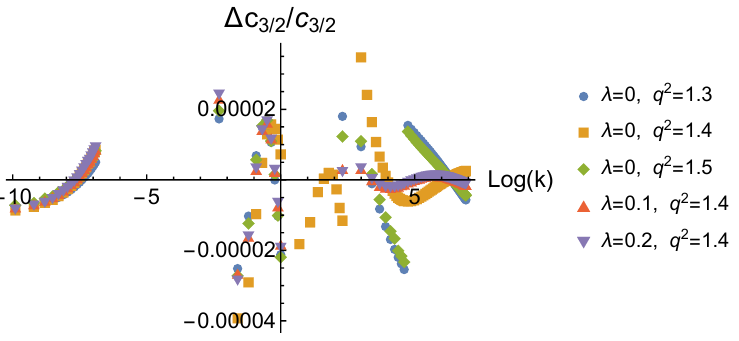
Figure 4 . Although k runs over 7 orders of magnitude, the errors between the conjectured for- mula (3.1) and the numerical data are very small, with | ∆ c